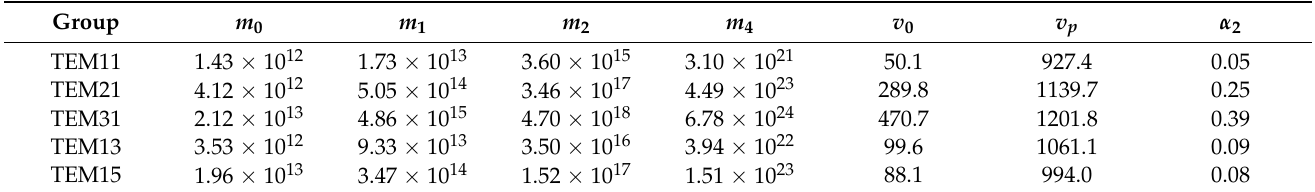
Table 5. Frequency domain characteristic parameters of axial compressive stress on the stress concentration node of the pressboard under different vibration